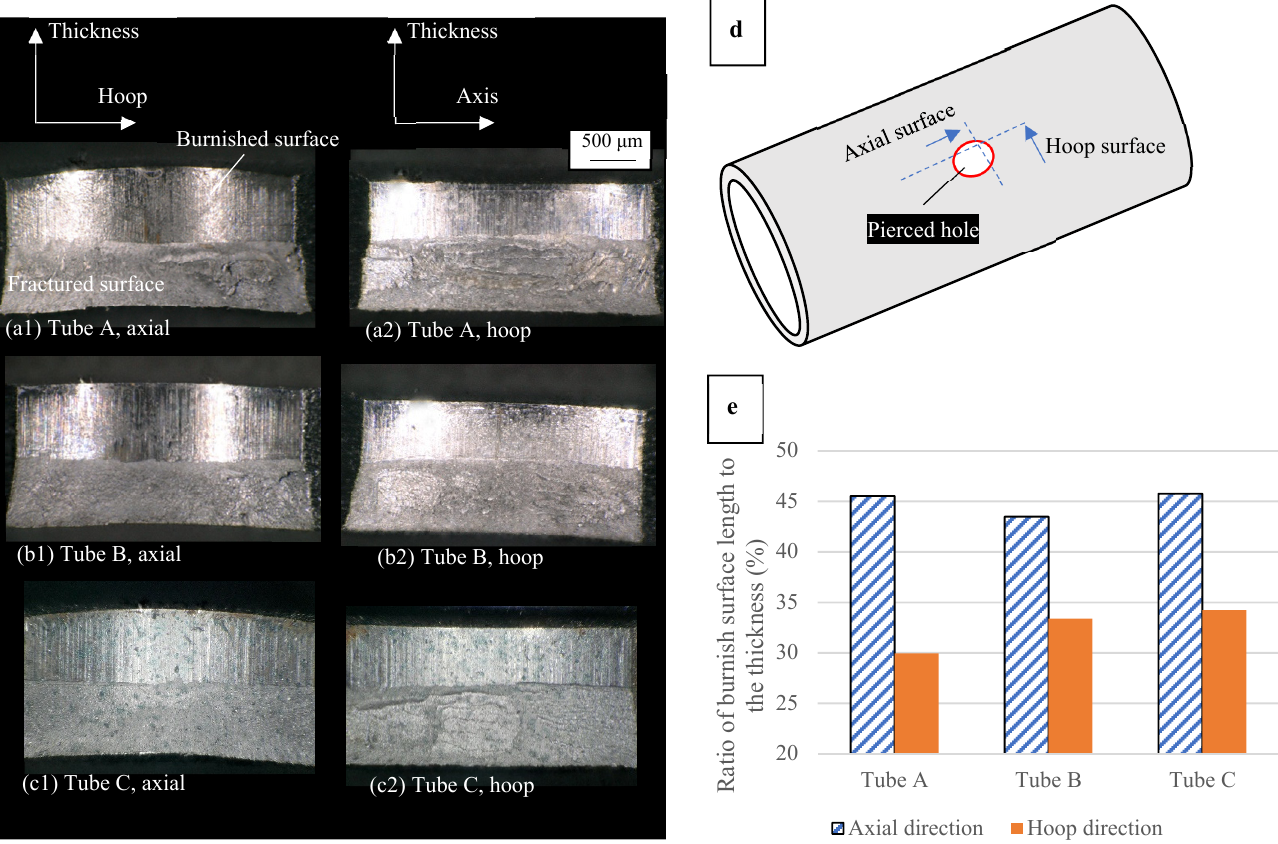
Figure 11. Pierced surface in each direction of the steel tubes. The figures ( a1 – c2 ) present the front face images of pierced surface in each direction. The figure ( d ) denotes the surface directions for ( a1 – c2 ). The figure ( e ) presents ratios of burnished surface lengths to the wall thickness. The values are evaluated from ( a1 – c2 ).